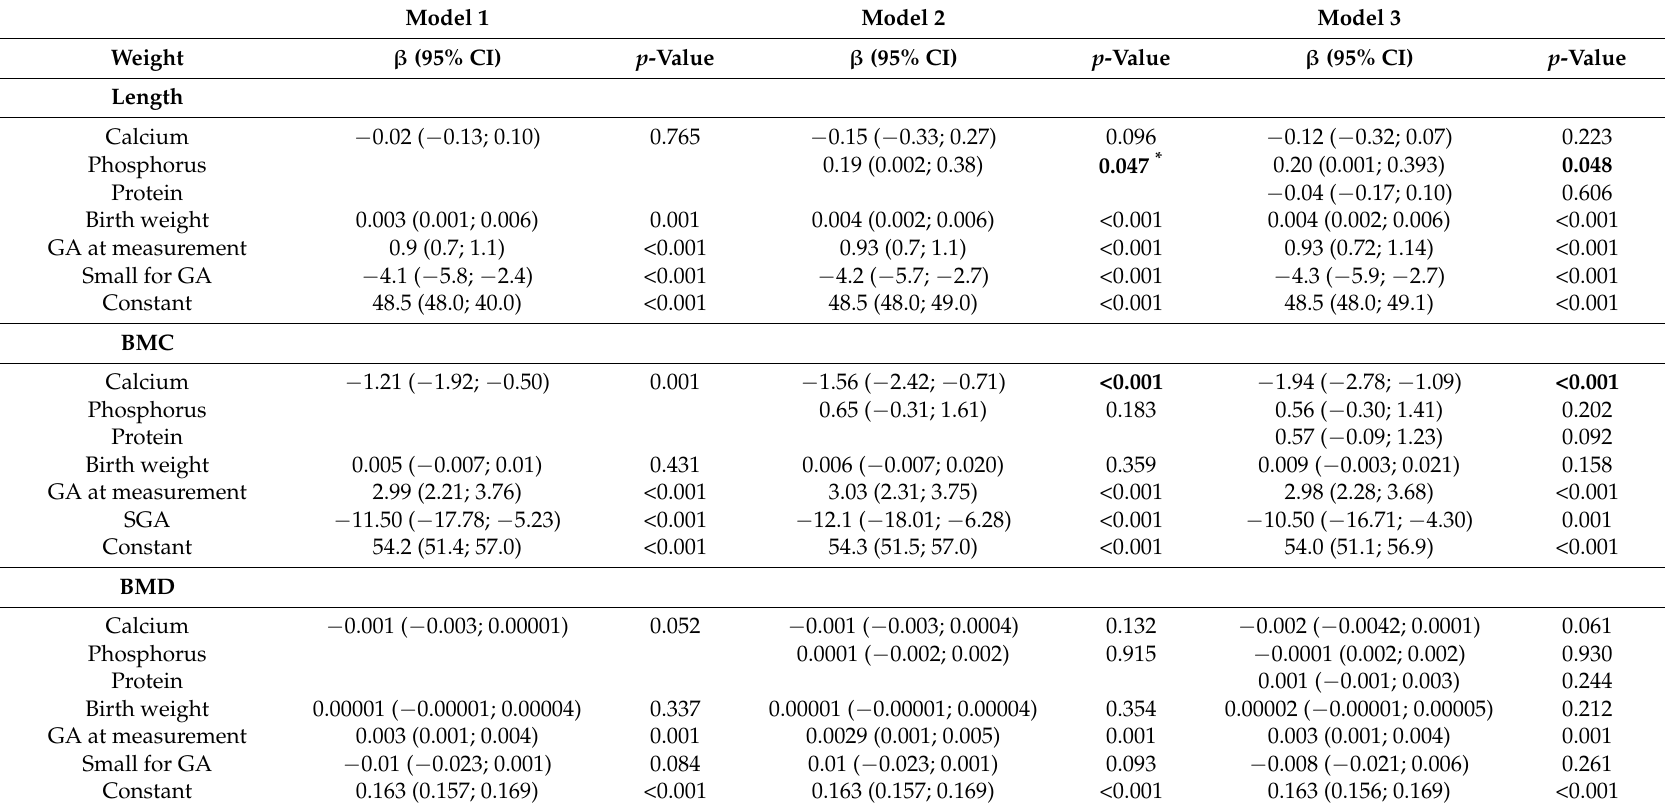
Table 7. Associations between nutritional intake and outcomes at term corrected